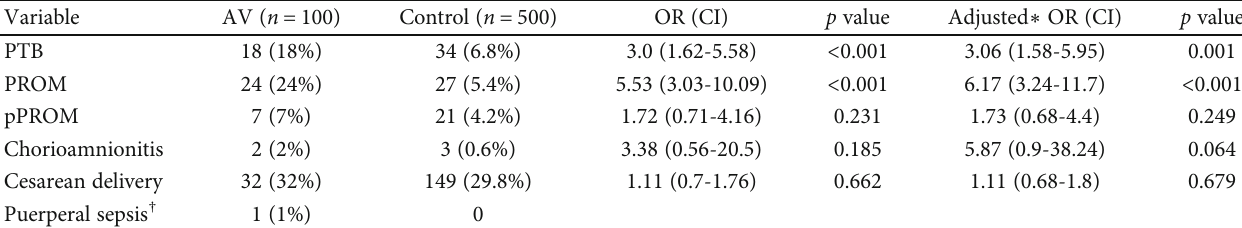
Table 2: Associations of maternal outcomes among pregnant women with aerobic vaginitis and without aerobic vaginitis.